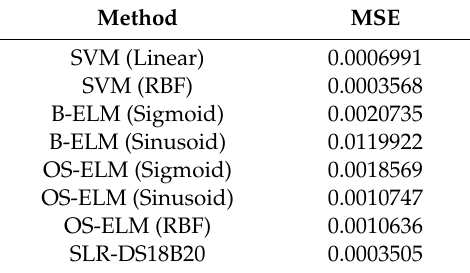
Table 3. Comparison